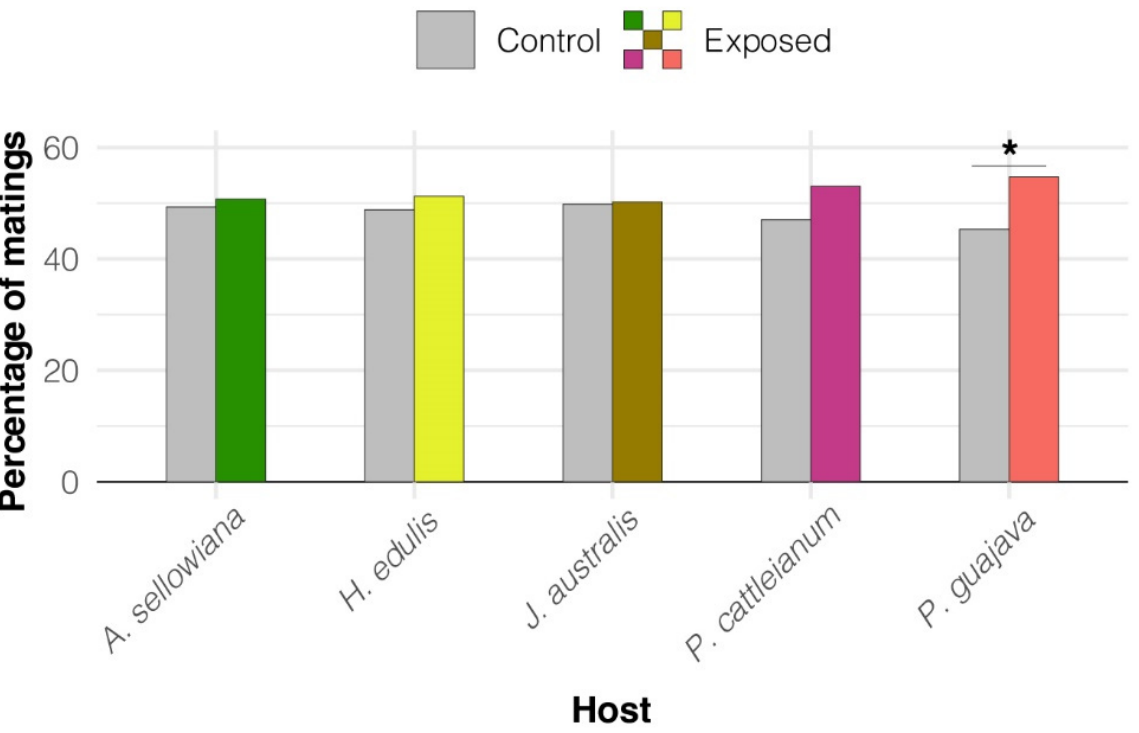
Figure 1. Effect of fruit volatile exposure on Anastrepha fraterculus sp. 1 male mating success. The figure shows the percentage of matings achieved by exposed and non-exposed (control) males for each native host fruit species. Asterisk indicates significant differences between exposed and non-exposed males ( p = 0.021). Table 2. Latency to mate and mating duration.